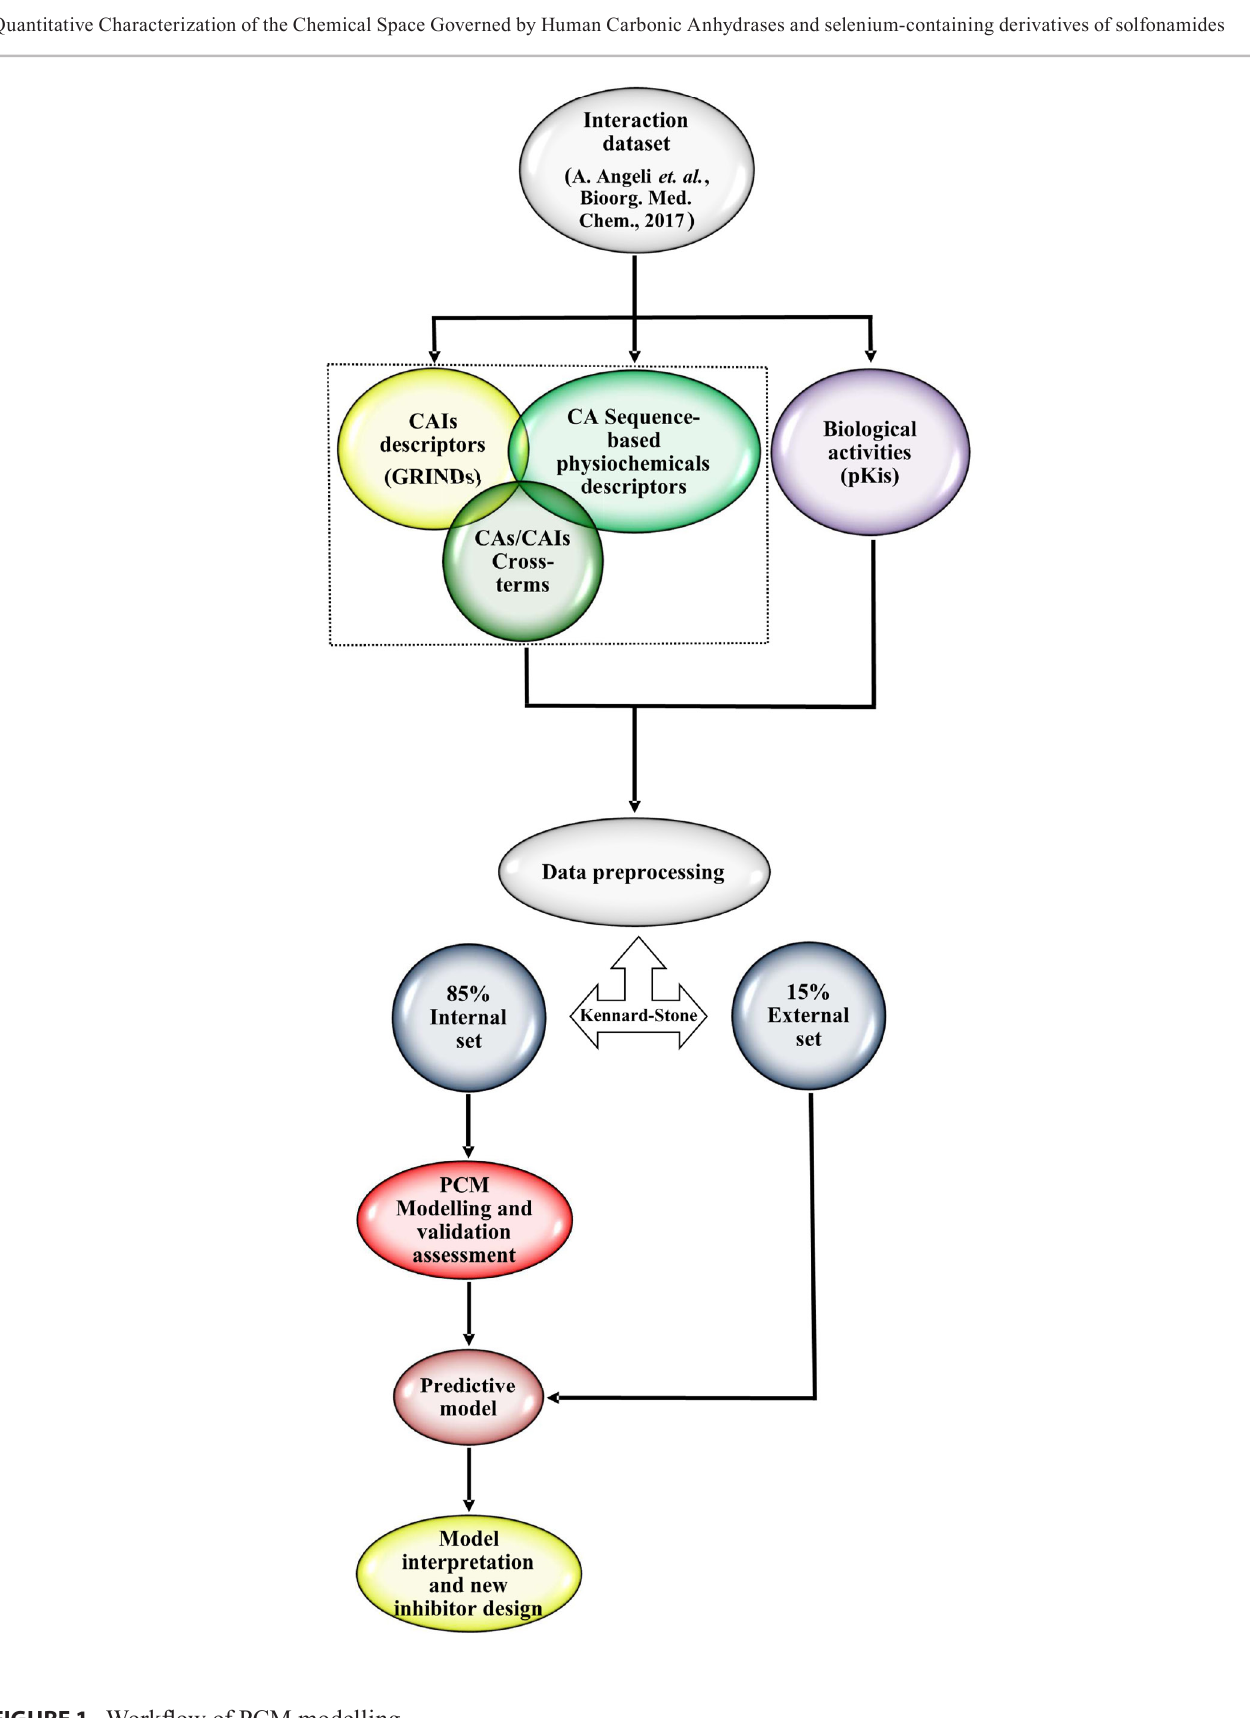
FIGURE 1 - Workflow of PCM